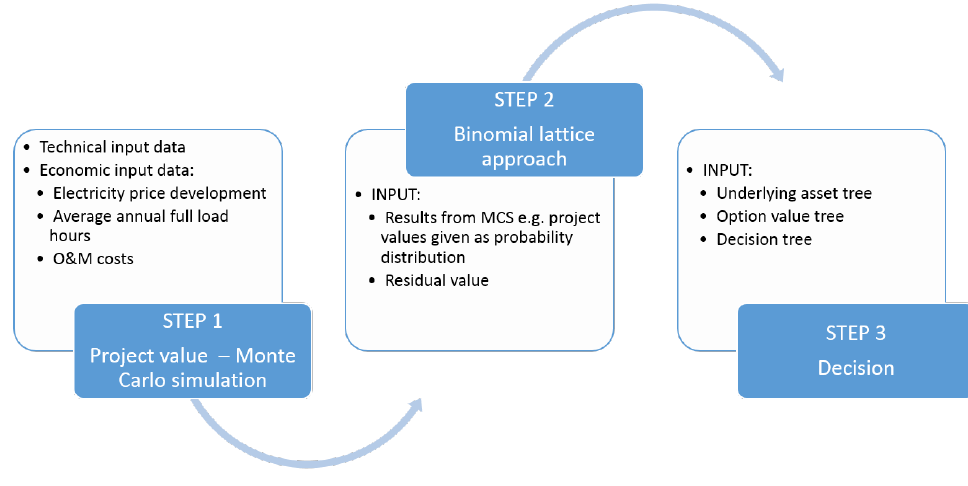
Figure 5. Proposed